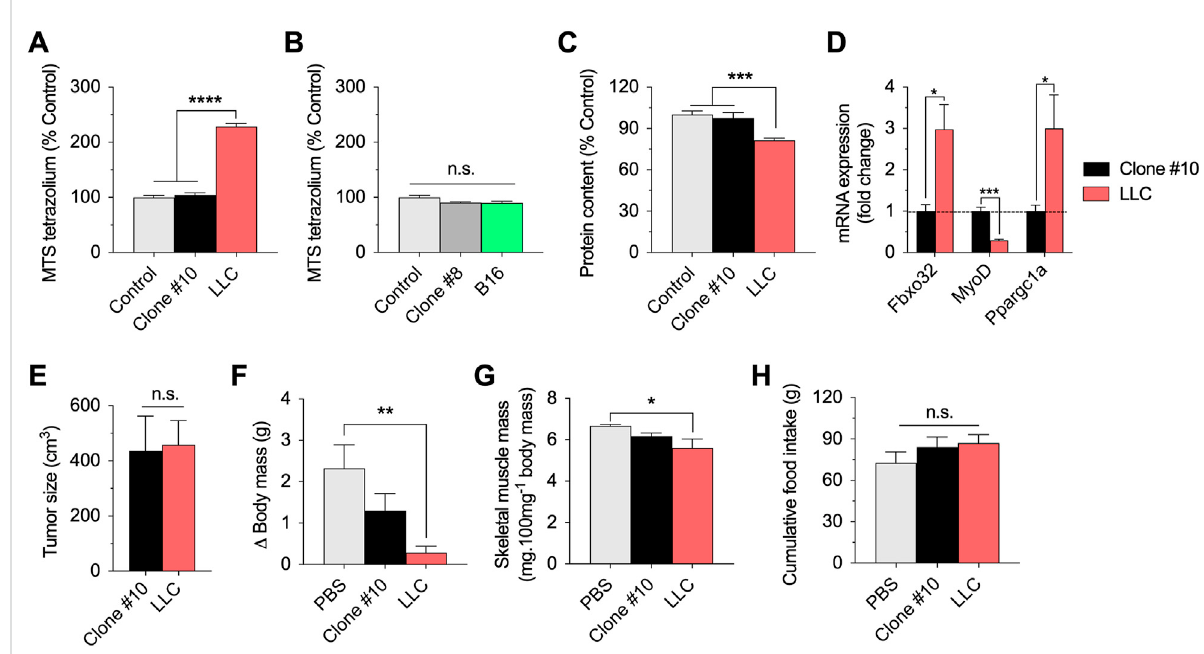
FIGURE 2 In vitro and in vivo effects of the selected LLC and B16 clones. (A,B) : Reduction of MTS tetrazolium compound in myotubes incubated for 12 h with parental or clonal LLC or B16-conditionedmedia. (C) :Total proteincontentinmyotubesincubatedfor 48 hwith parental LLC or LLCclone#10 -conditioned media. (D) : mRNA expression of key regulators of muscle function in myotubes incubated with parental LLC or LLC clone #10- conditioned media. Data is normalized using untreated myotubes. (E – G) : Tumor growth (E) , changes in body (carcass) mass (F) , sum of gastrocnemius and plantaris muscle mass normalized by initial body mass (G) , and cumulative food intake (H) in LLC tumor-bearing mice 21 days post injection. Data are presented as mean ± standard error of the mean. n = 3 technical replicates for all measurements. n = 5 mice/group (one mouse from the LLC group died before 21 days and data was not collected/plotted). * p < 0.05; ** p < 0.01; *** p < 0.001; **** p <